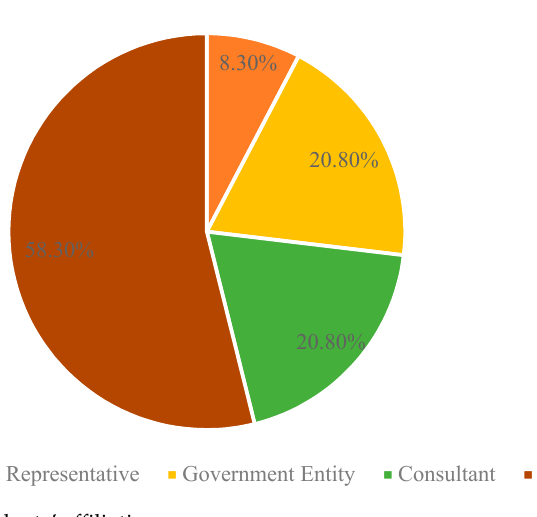
Figure 2. Respondents’ affiliation.